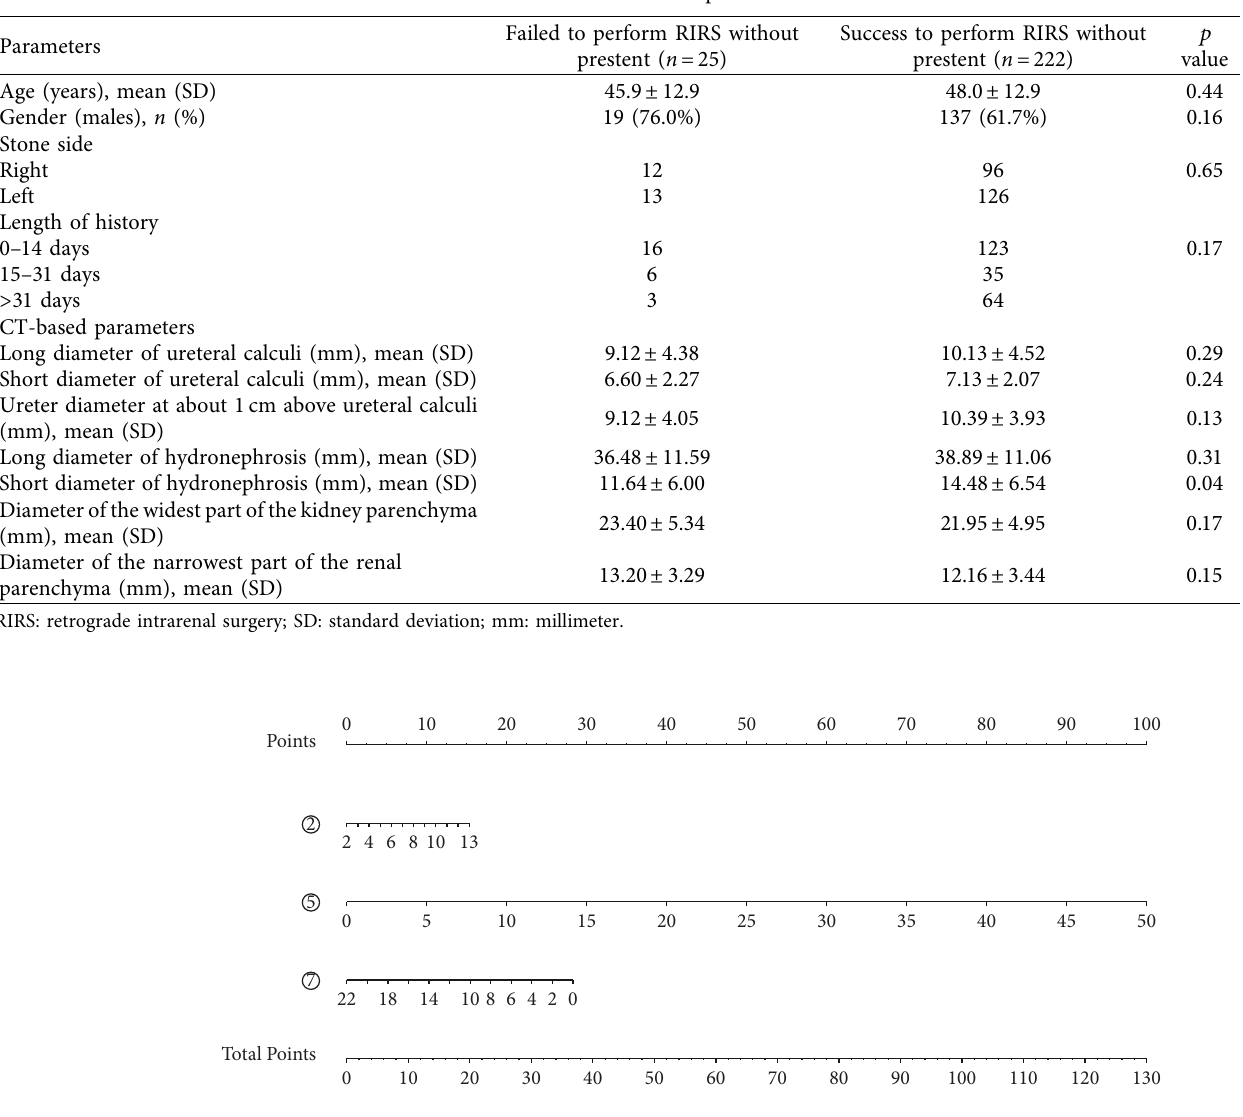
Table 1: Characteristics of